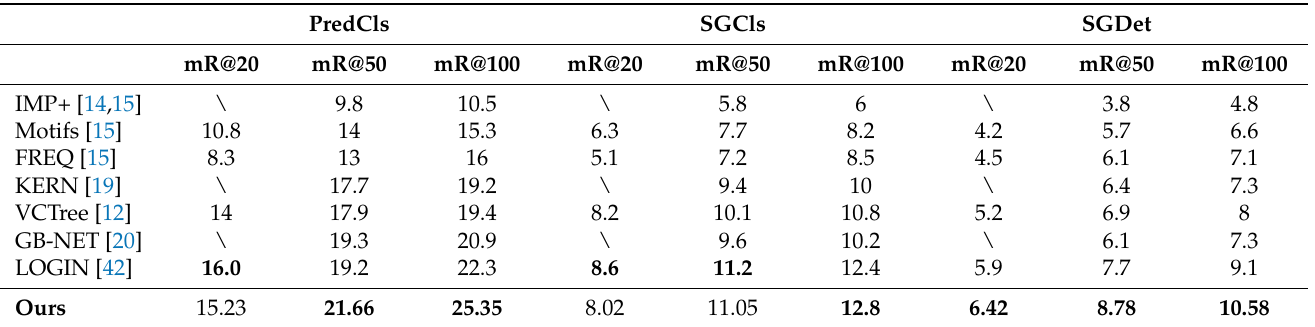
Table 3. Comparison of the mR@20, mR@50, and mR@100 metrics in % between our model and existing